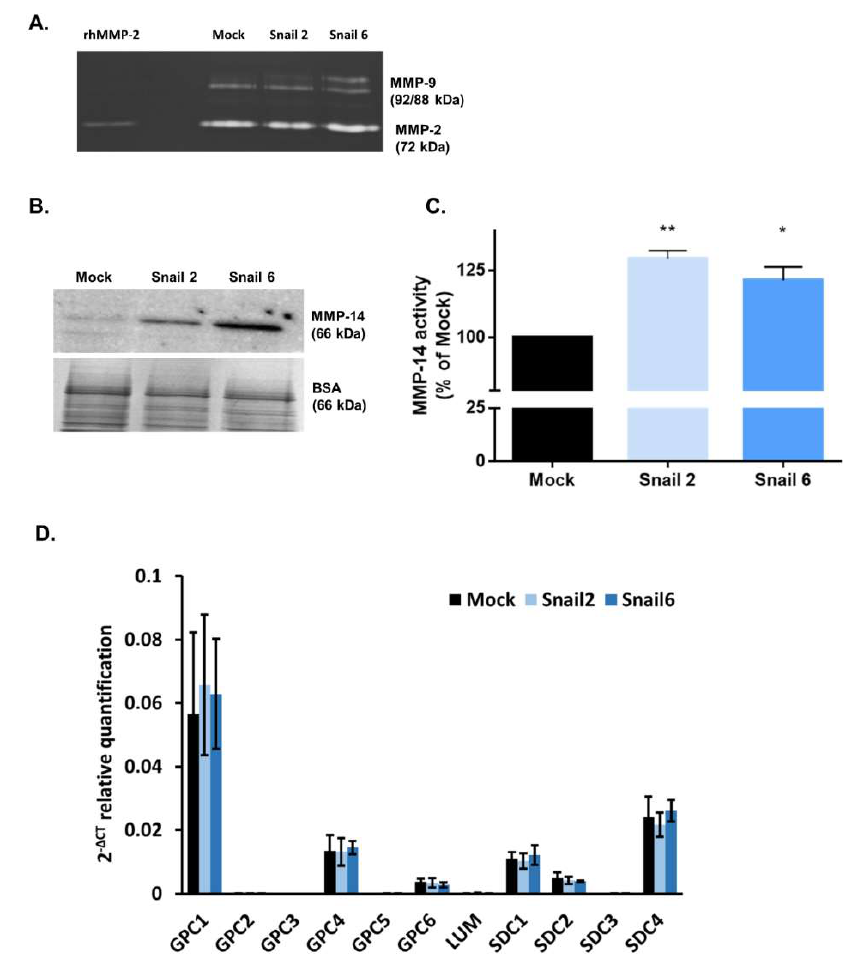
Figure 2. Effect of Snail on matrix metalloproteinase (MMP)-2, -9, and -14 activity and proteoglycan gene expression in MC38 cells. ( A ) Zymography analysis for MMP-2 and MMP-9 activity in Mock and in Snail-MC38 clones. Control: recombinant human MMP-2. ( B ) Western blot analysis of MMP-14 protein expression in Mock and in Snail-MC38 clones. The total protein normalization (TPN) method was used. ( C ) MMP-14 activity in Snail-overexpressing MC38 clones expressed as percentage of Mock, * p < 0.05, ** p < 0.01. Data are shown as median with interquartile range. ( D ) Real-time RT-PCR analysis of proteoglycans expression in Mock and Snail-overexpressing MC38 cells; n ≥